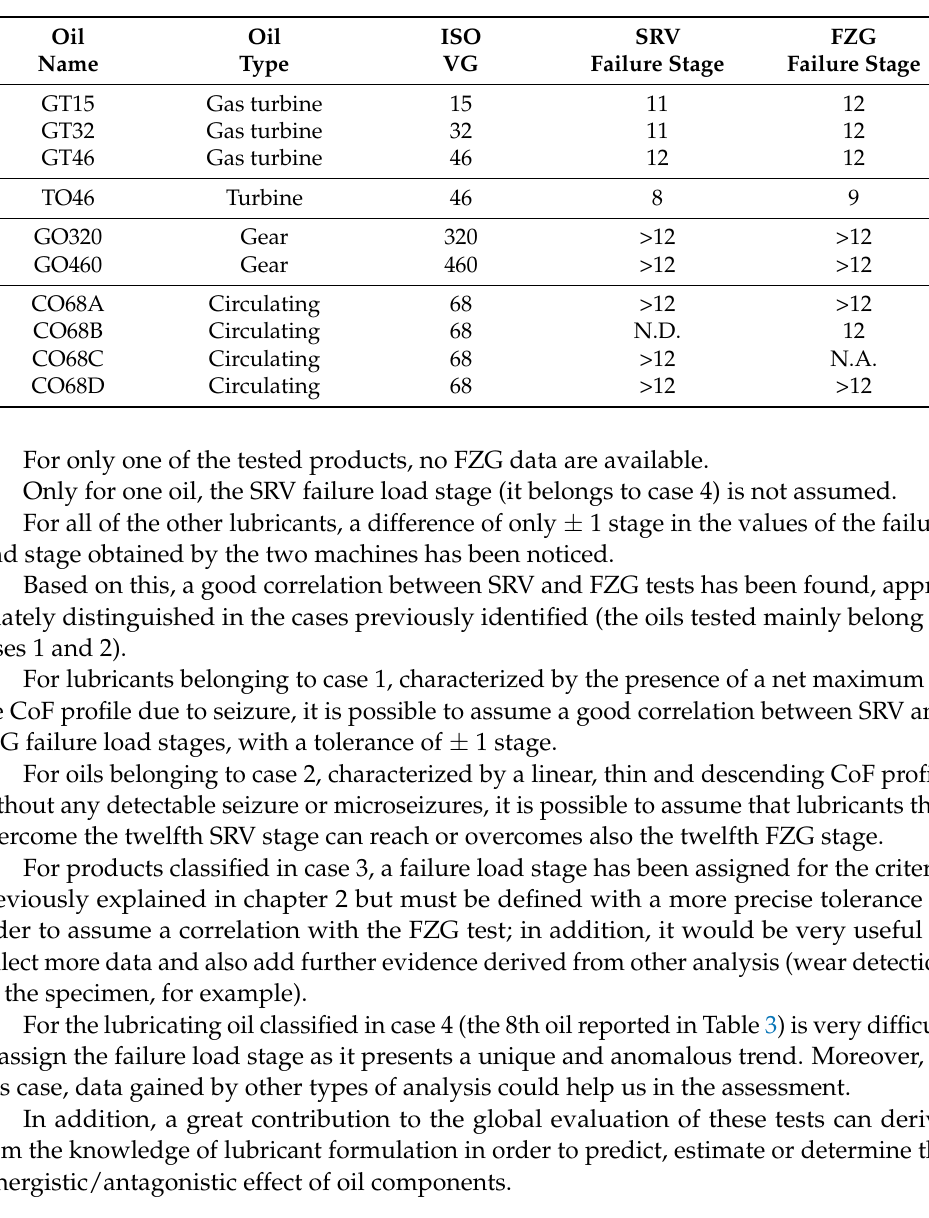
Table 3. Experimental results: laboratory and rig